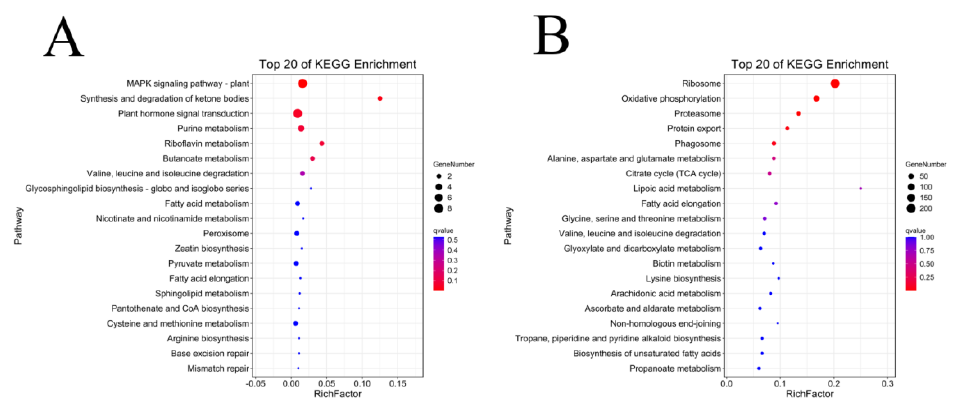
Figure 11. KEGG enrichment analysis of genes in target module (Xinluzao 50 and Xinluzao 50 FLM): ( A ) MEred module; ( B ) MEyellow module.